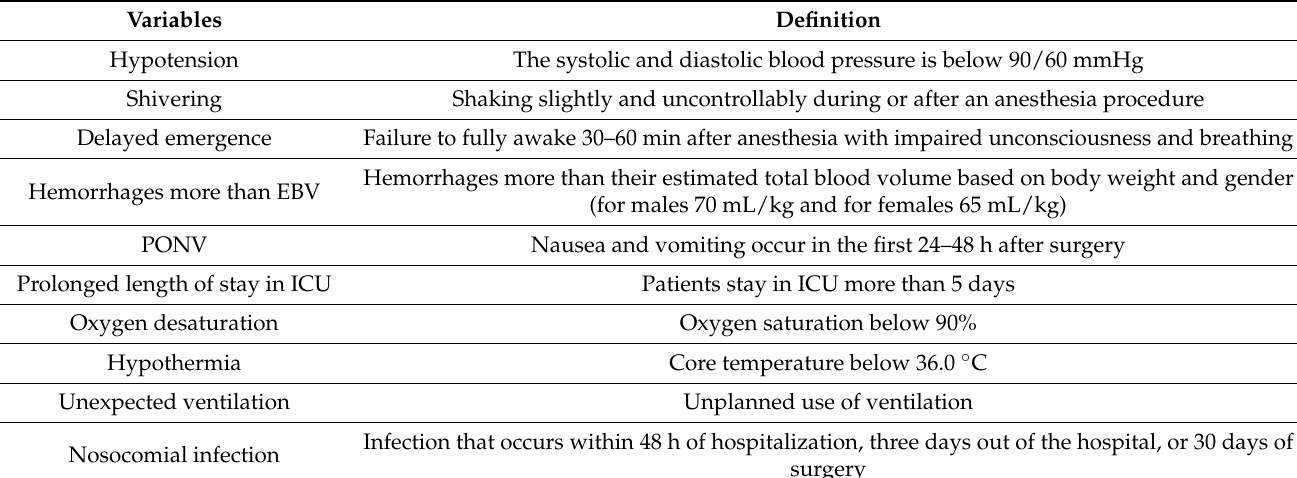
Table 1. Parameter definition of